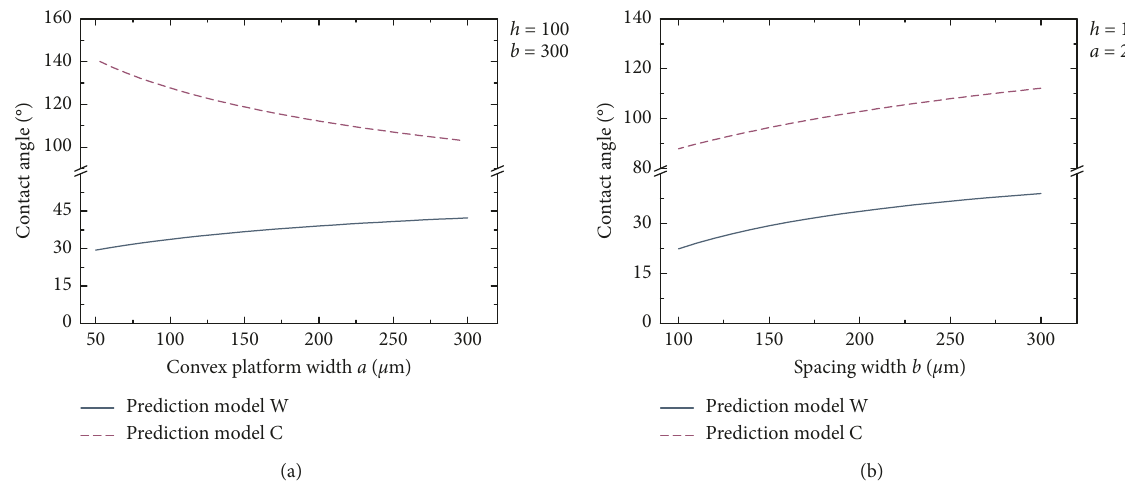
Figure 4: Law between structural parameters and contact angle: (a) convex platform width; (b) spacing width.